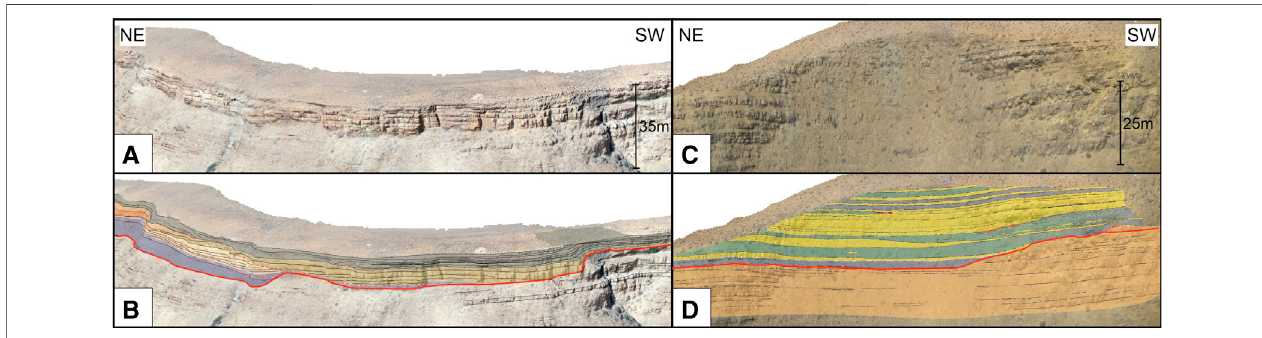
FIGURE 9 | Images from photogrammetric models built from uncrewed aerial vehicle images of giant scour- fi lls in interpreted channel-lobe transition zones. (A) uninterpreted and (B) interpreted images ofscour- fi llinFan 3 at KleineReit Fontein, Tanqua Depocentre,Karoo Basinand (C) Uninterpreted and (D) interpretedimages of a scour- fi ll in Unit A5 at Wilgerhout, Laingsburg Depocentre, Karoo Basin. Colours relate to sedimentary facies, which are described in detail in Hofstra et al. (2015).